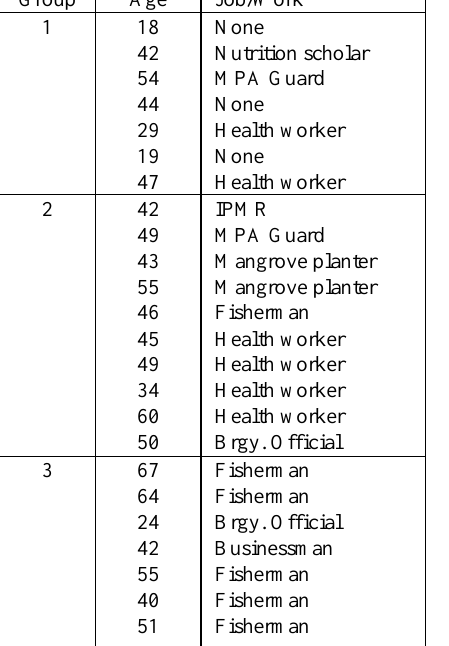
Table 1. Assigned groups of the 24 residents of Busuanga who volunteered for the participatory mapping